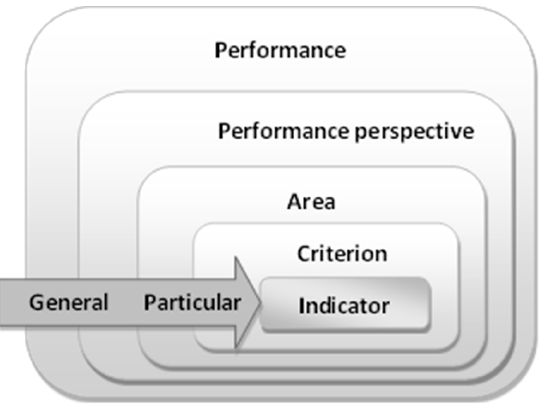
Figure 1. Hierarchy of concepts that are considered in the performance of a building.